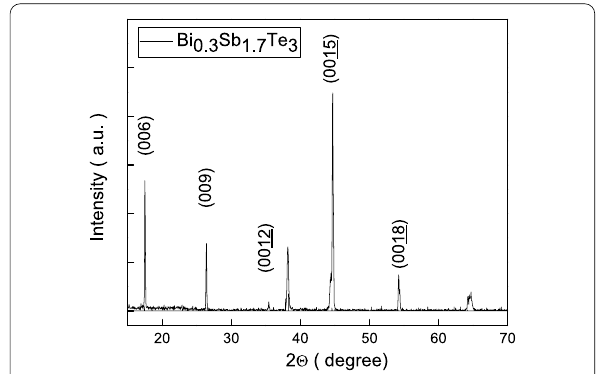
Fig. 1 The XRD spectrum of the Bi 0.3 Sb 1.7 Te 3 single crystal. It reveals sharp peaks that support the highly single crystallized